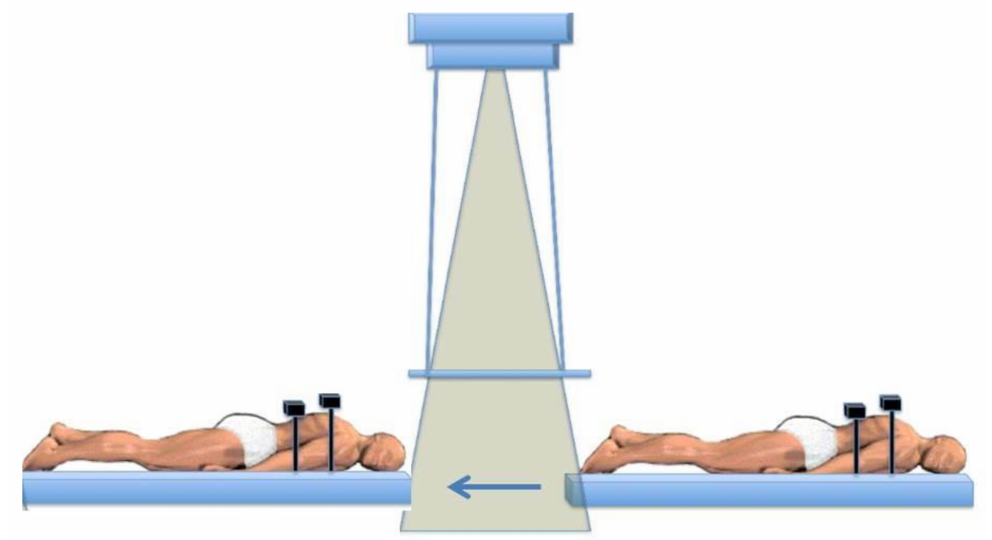
Figure 1. Schematic diagram of a translating-bed technique for total body irradiation (TBI) with the patient being moved through the radiation beam with lung and kidney attenuators in